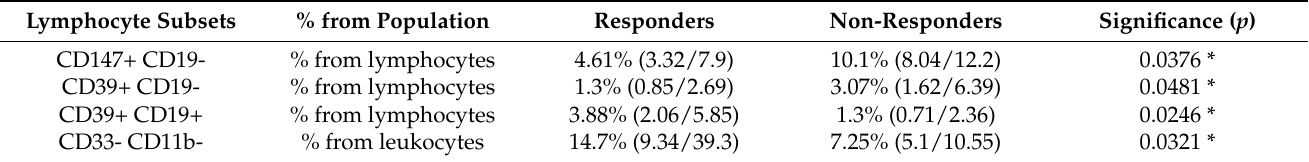
Figure 2. Lymphocytes. The top row shows the % positive from the parent population for responders and non-responders. Left column: responders; right column: non-responders. The bottom row shows the FACS gating. Left ( A ) : CD33- CD11b- population % from leukocytes, associated with response. Middle ( B ) : CD147+ CD19- lymphocytes % from lymphocytes, associated with treatment failure. Right ( C ) : CD39+ CD19- lymphocytes % from lymphocytes, associated with treatment failure and CD39+ B cells, associated with response. Significance was indicated as * p < 0.05. Table 4. Lymphocyte subsets and metabolic